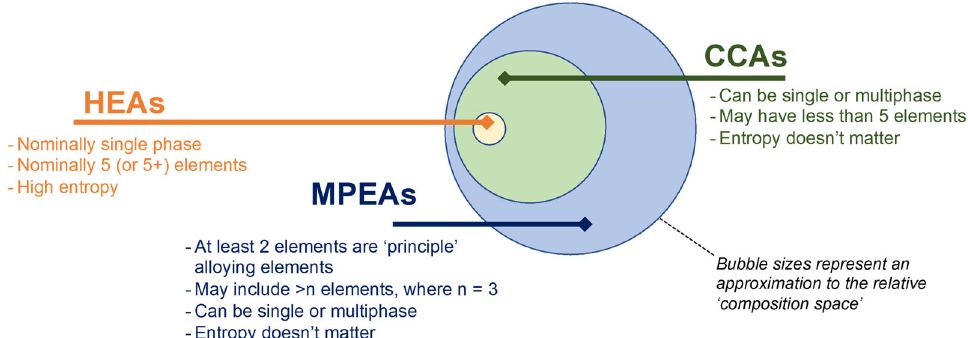
Fig. 1 A schematic representation of the classi fi cation notions for multi-principal element alloys (MPEAs). HEAs may be considered as a subset of CCAs; which in turn may also be considered a subset of the broader description of MPEAs — whereby the terminology of MPEAs encompasses a broad range of new and emerging metallic Figure 2 also indicates the key funding sources supporting research in the fi eld.